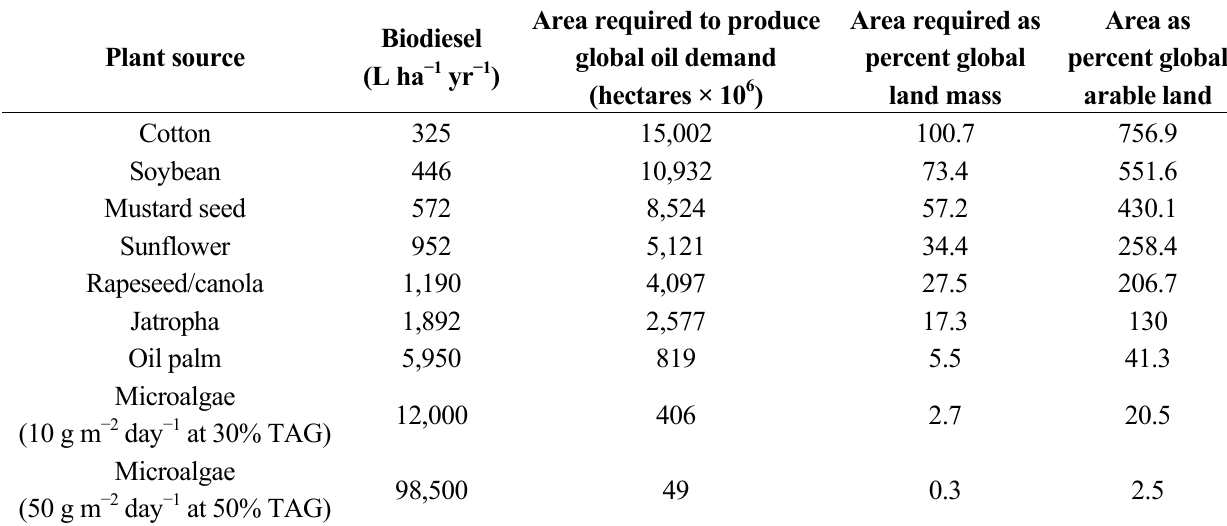
Table 1. Comparison of crop-dependent biodiesel production efficiencies from plant oils [2]. TAG: